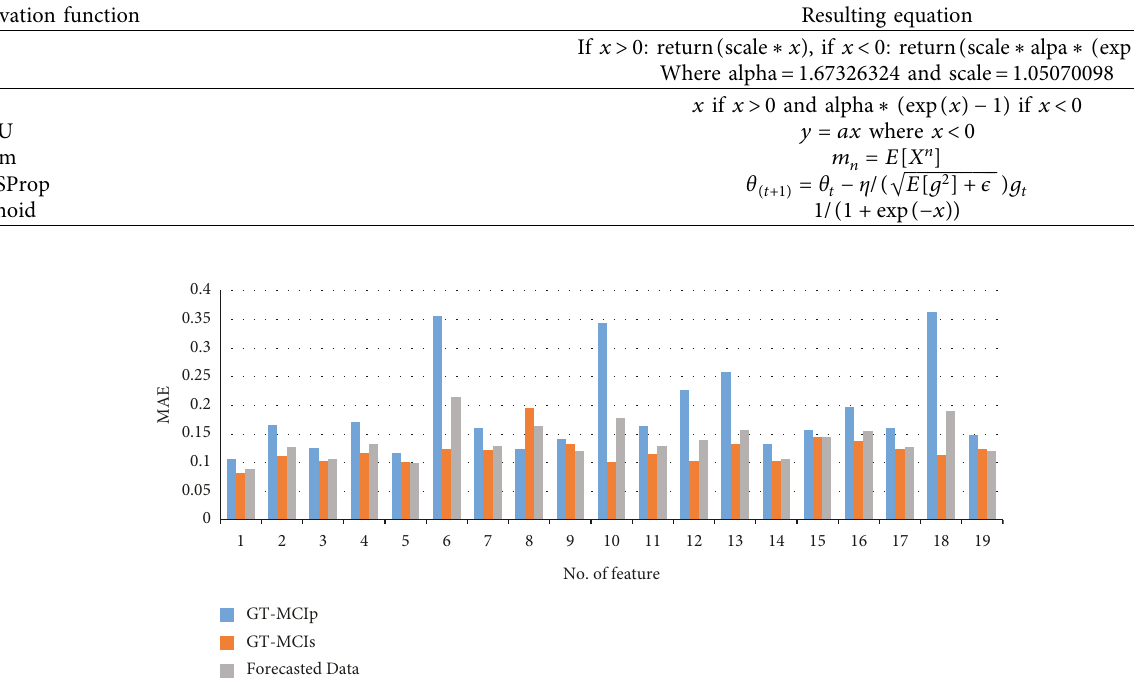
Figure 2: Mean absolute error (MAE) recorded for the best-performing regression